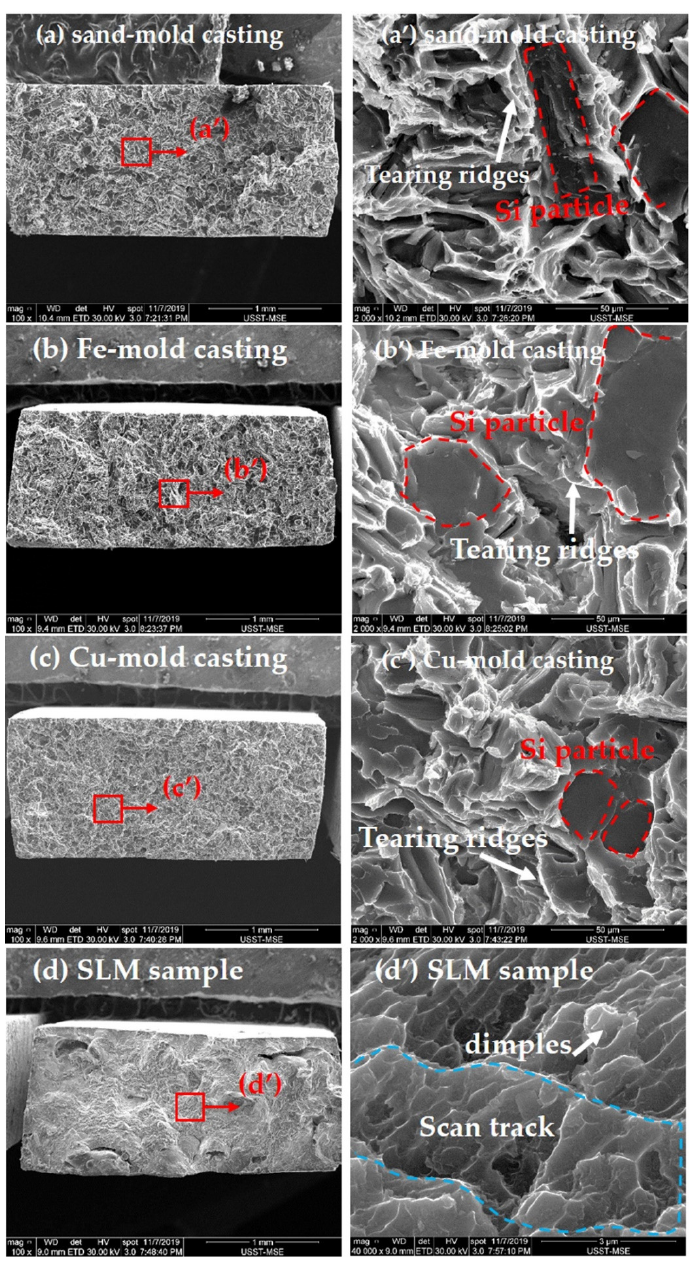
Figure 11. Tensile fractographies of Al-10Si-0.5Mg alloys prepared under different conditions. Left column ( a – d ) low magnification, right column ( a’ – d’ ) higher magnification of the area marked by boxes and arrows. Note that the magnification of ( d’ ) is higher as 40,000× to show fine microstruc- ture.